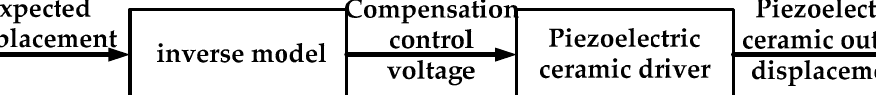
Figure 17. Experimental setup.